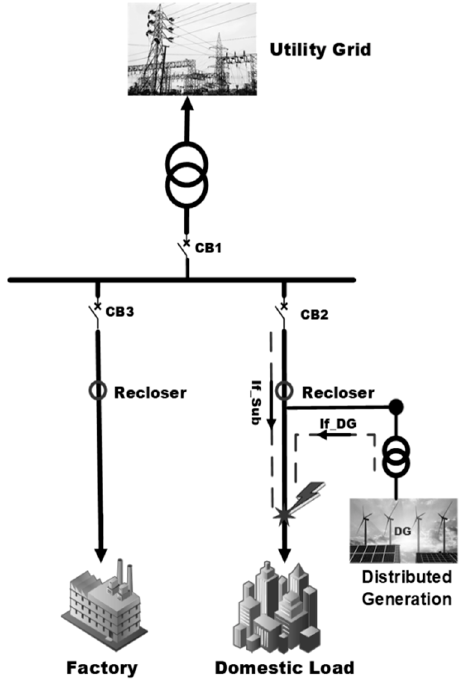
Figure 7. Recloser coordination in the presence of DG.